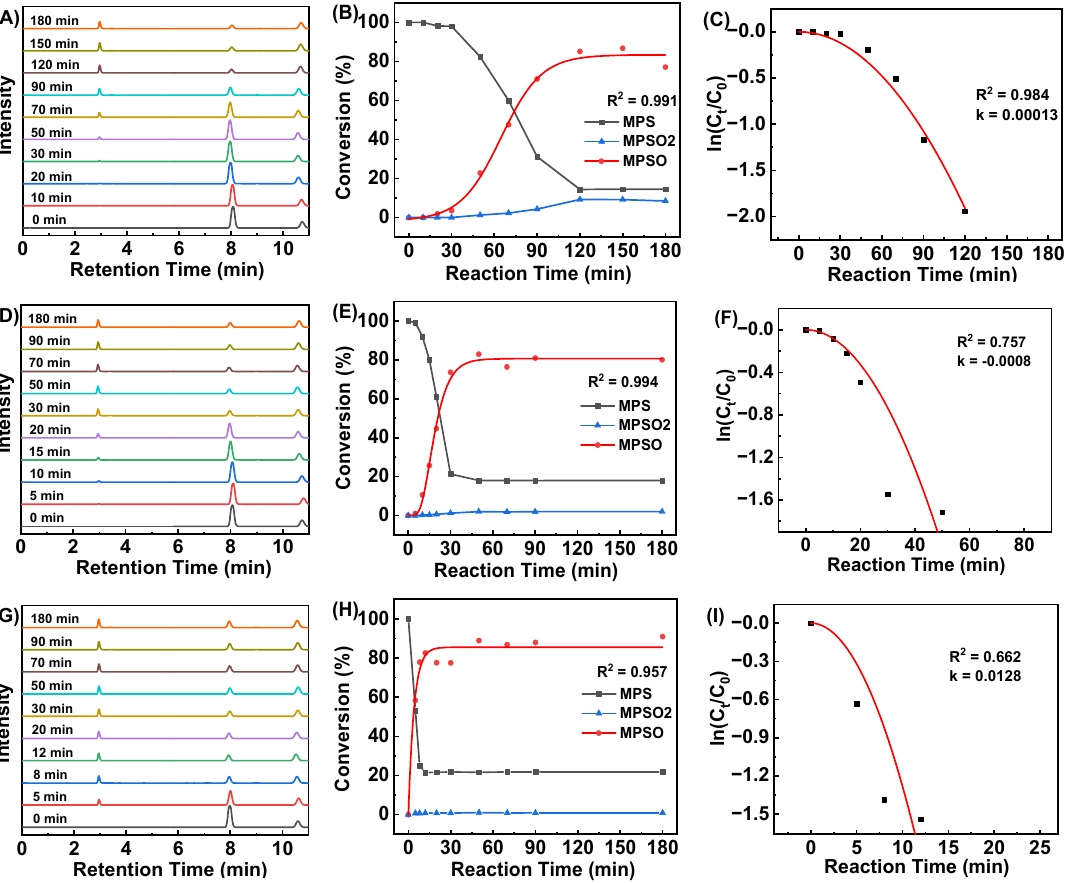
Figure 5. HPLC, conversion, and kinetics curves during the catalytic oxidation of MPS by 1/400 eq of HCCP-V and 1.0 eq of H 2 O 2 at different temperatures: ( A – C ) 25 °C, ( D – F ) 40 °C, and ( G – I ) 55 °C. Naphthalene with a retention time of 10.2 min was used as an internal standard. Table 1. The catalytic oxidation results of MPS by HCCP-V in CH 3 CN.